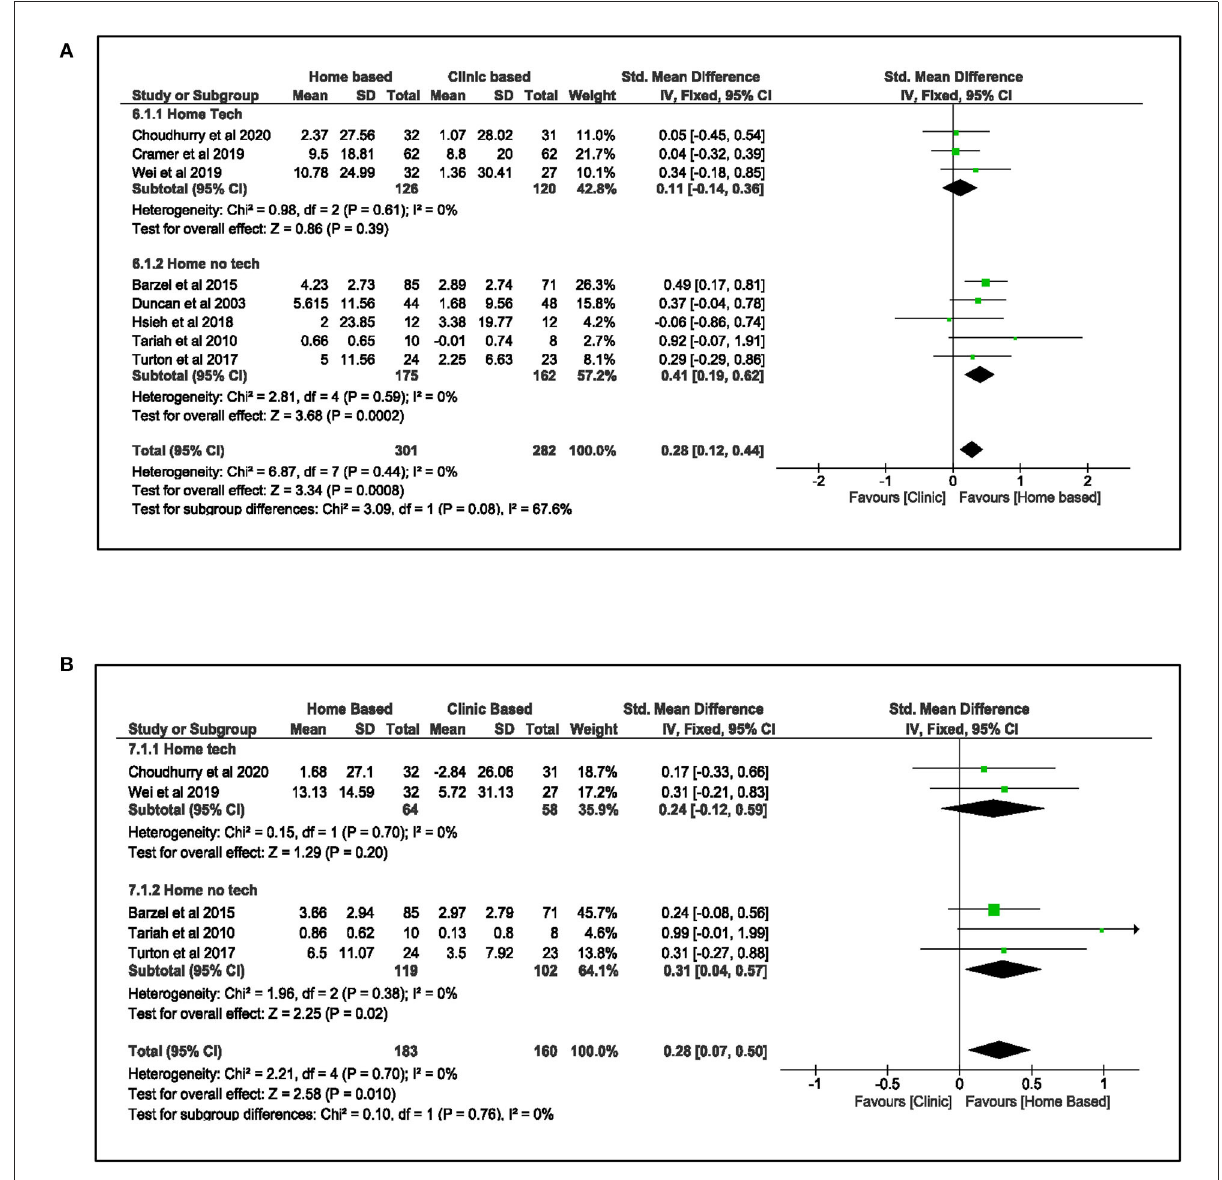
FIGURE2 Comparison of the effect of home-based intervention and conventional therapy on UL function (A) standardized mean difference (SMD) immediately after the treatment. (B) Standardized mean difference (SMD) at